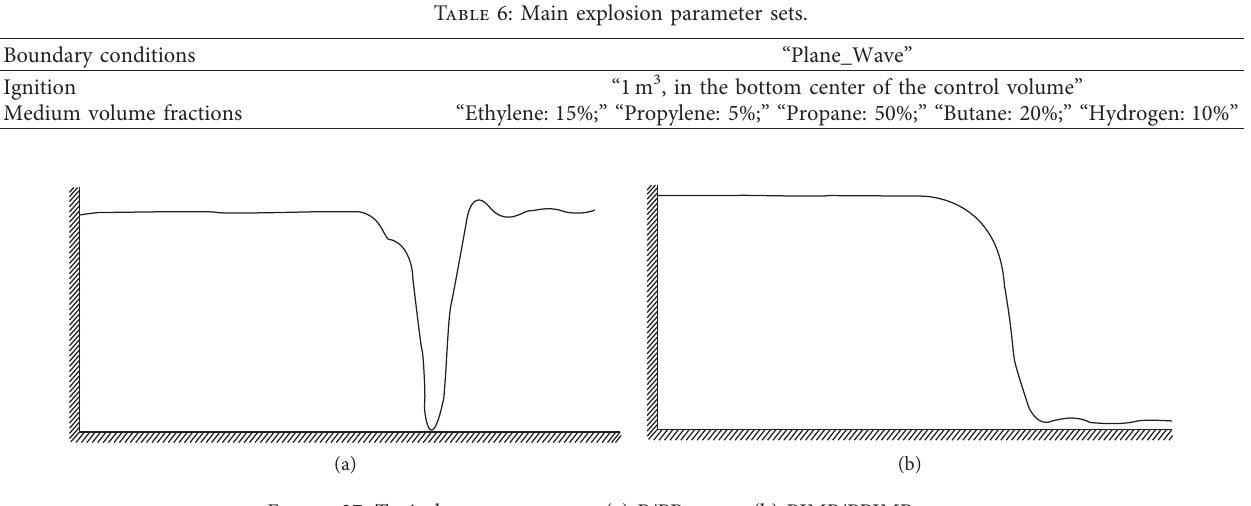
Figure 27: Typical pressure output: (a) P/PP curve; (b) PIMP/PPIMP curve.